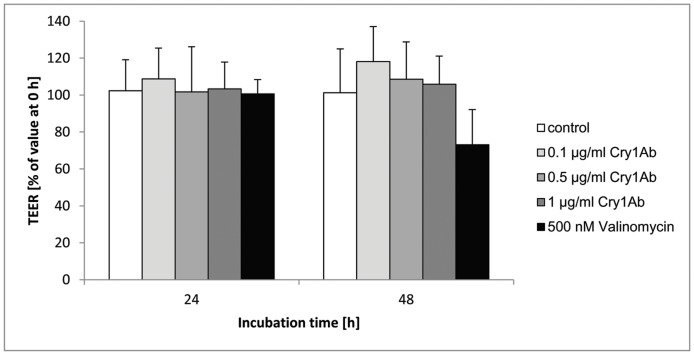
Effect of Cry1Ab on transepithelial electrical resistance (TEER) in porcine intestinal epithelial monolayers.TEER of IPEC-J2 cell monolayers was measured 24 h and 48 h after application of increasing doses of Cry1Ab (0.1, 0.5, 1 µg/ml) or valinomycin (500 nM) at the apical side [means ± standard deviation; % of initial value t  = 0 h]; n = 3 independent experiments (2–3 cell culture inserts per treatment group per experiment).